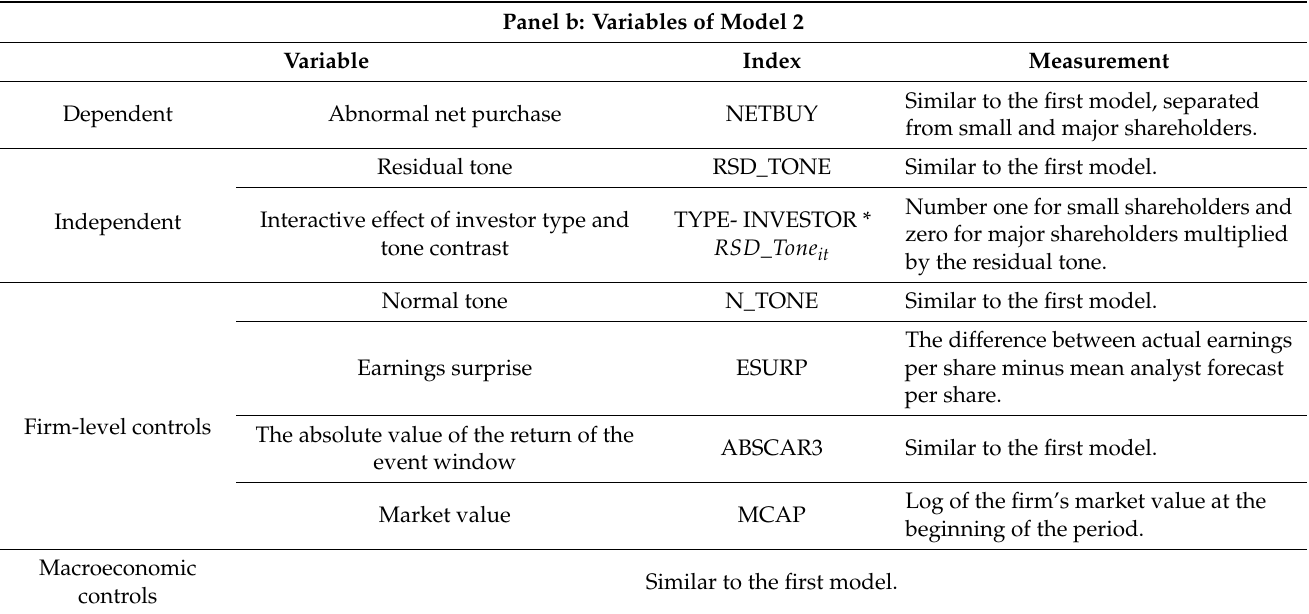
Table 2. Cont. Panel b: Variables of Model